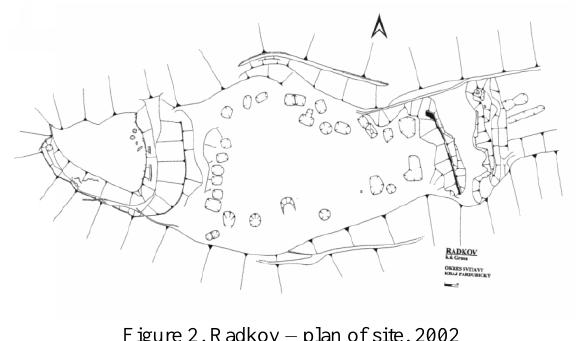
Figure 2. Radkov – plan of site, 2002